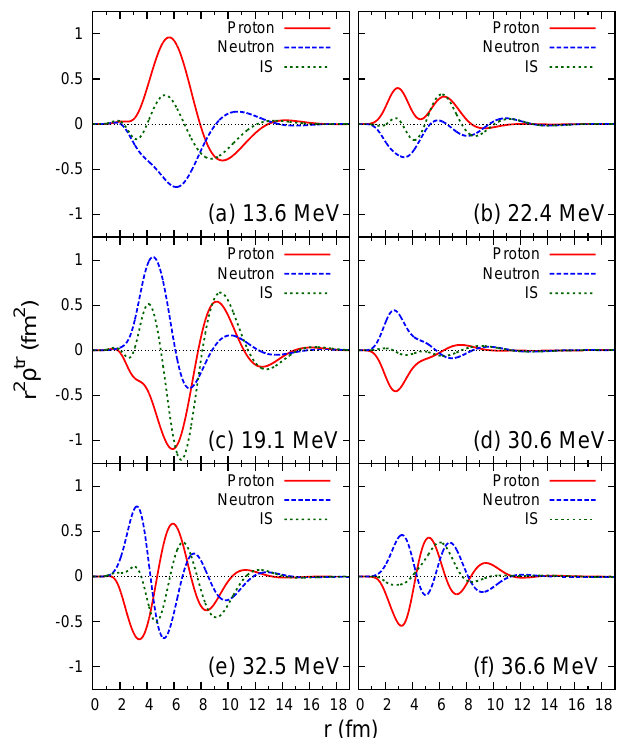
Figure 6: Same as Fig. 5 but with u = 0.87 at the same E